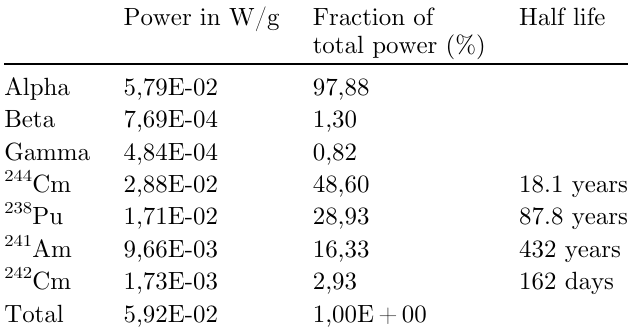
Table 1. Main heat emitters in a MABB cooled for 5 years after 4100 EFPD of irradiation, with 75% 241 Am and 25% of 243